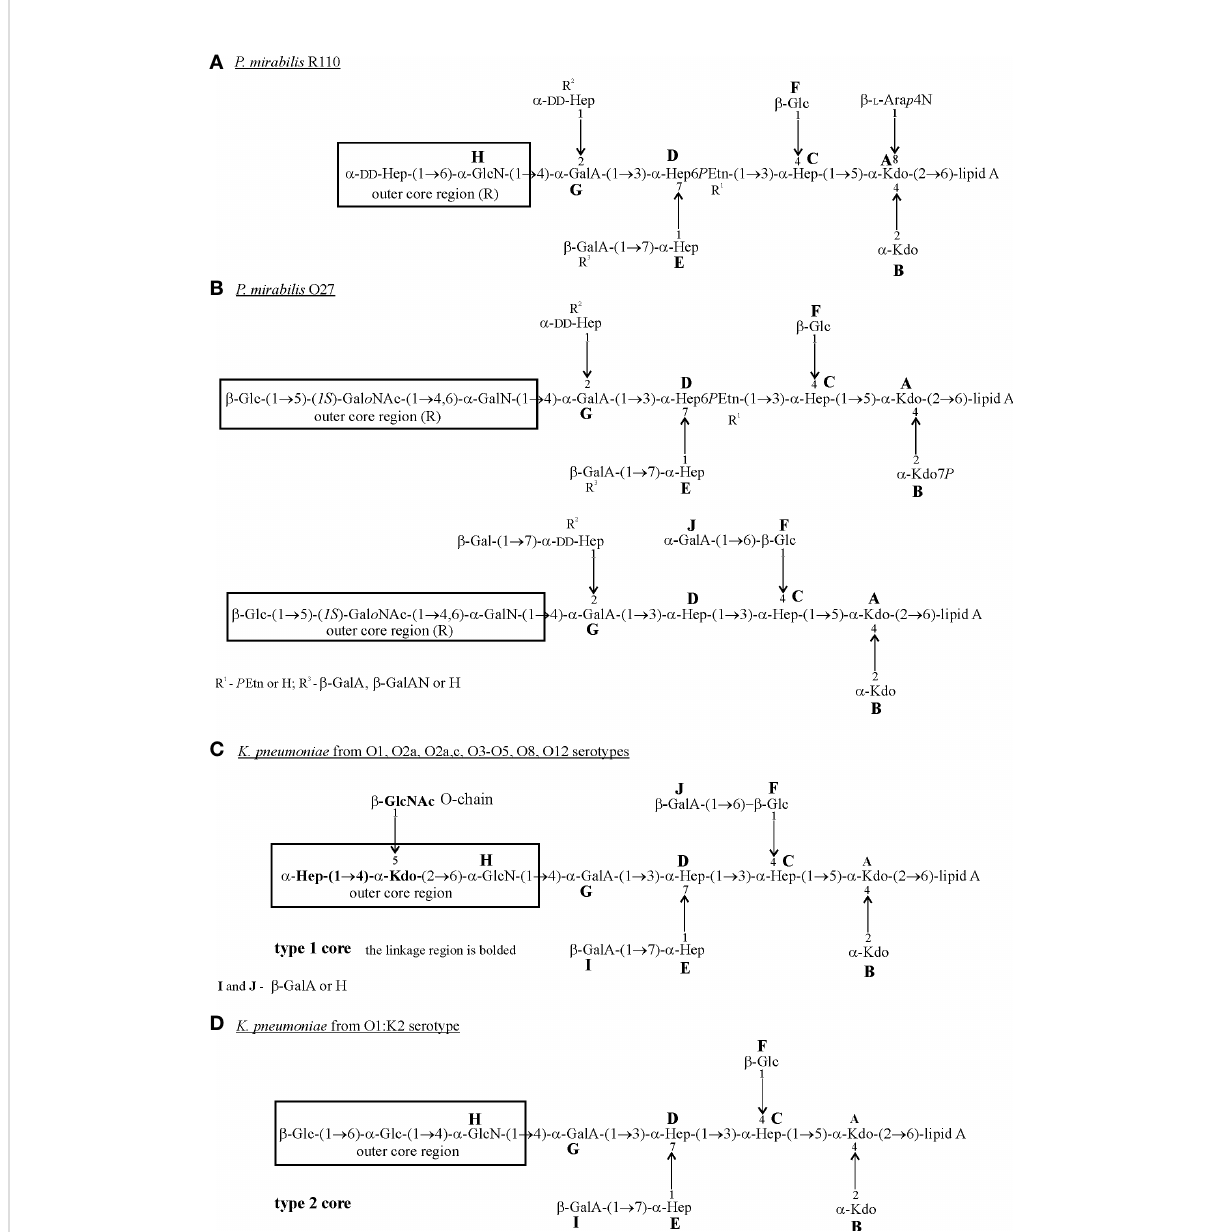
FIGURE 1 Structures of the core regions of: (A) P. mirabilis R110; (B) P. mirabilis O27; (C) K. pneumoniae from O1, O2a, O2a,c, O3-O5, O8 and O12 serotypes; (D) K . pneumoniae from the O1:K2 serotype (Vinogradov et al., 2000; Vinogradov and Perry, 2001; Vinogradov et al., 2002; Regue ́ et al., 2005; Holst, 2007). The outer core region (R) is indicated by the frame. Ara p 4N, 4-amino-4-deoxy-L-arabinopyranose; GalA, galacturonic acid; GalAN, GalA amidated by aliphatic polyamines; GalN, galctosamine; Gal o NAc, open-chain of GalNAc; Glc, glucose; GlcN, glucosamine; GlcNAc, 2-acetamido-2-deoxy-D-galactose; LD-Hep, L- glycero -D- manno -heptose; DD-Hep, D- glycero -D- manno -heptose; Kdo, 3-deoxy-D- manno -oct-2-ulosonic acid; P Etn,2-aminoethyl